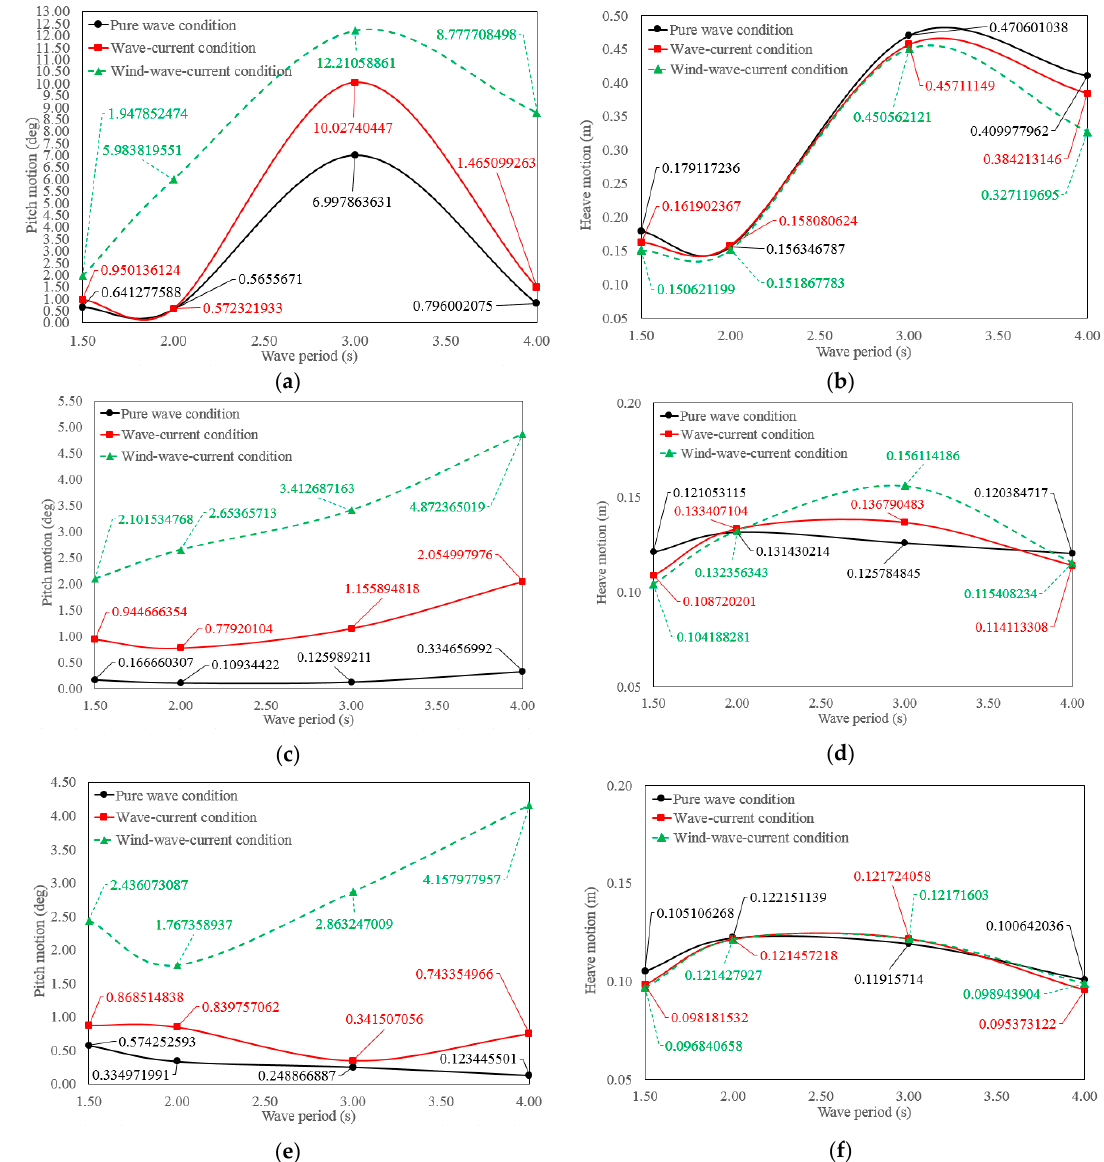
Figure 10. Respective influences of wind, wave, and current loads on the motions of the turbine. ( a ) Pitch, supported by spar without using stabilizer; ( b ) heave, spar without using stabilizer; ( c ) pitch, spar using a single plate stabilizer; ( d ) heave, spar using a single plate stabilizer; ( e ) pitch, spar using the new concept of stabilizer; and ( f ) heave, spar using the new concept of stabilizer.